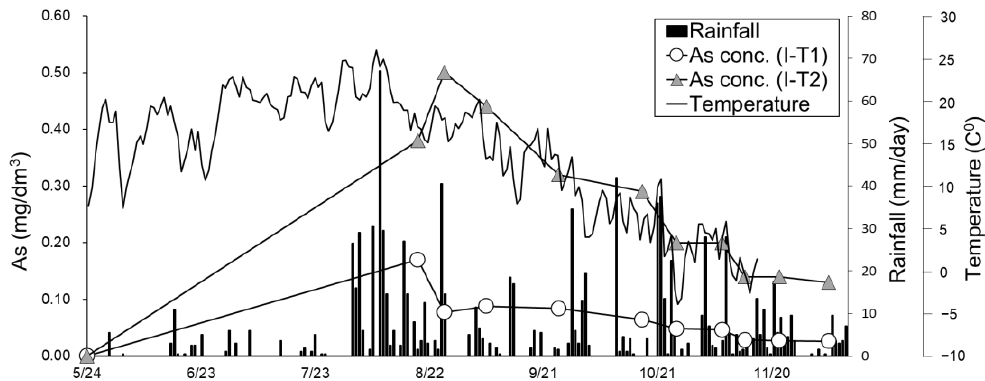
Figure 9. Changes in As concentration, precipitation and temperature under in situ conditions in cases of I-T1 and I-T2.